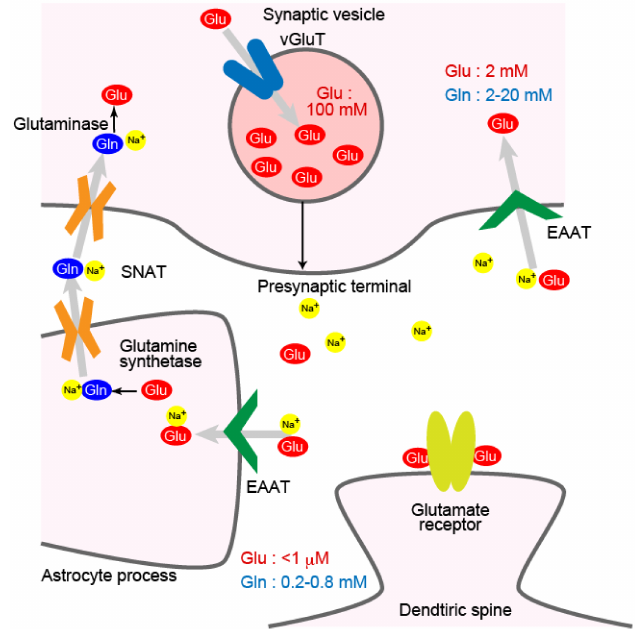
Figure 1. Localization of glutamate transporters and glutamine transporters around an excitatory synapse. Plasma membrane glutamate transporter EAATs are on the plasma membrane of presynaptic terminals and astrocyte processes. Vesicular glutamate transporter vGluTs are on synaptic vesicles. SNATs transports glutamine at the plasma membrane of neurons and astrocytes. Concentrations of glutamate and glutamine in each compartment are